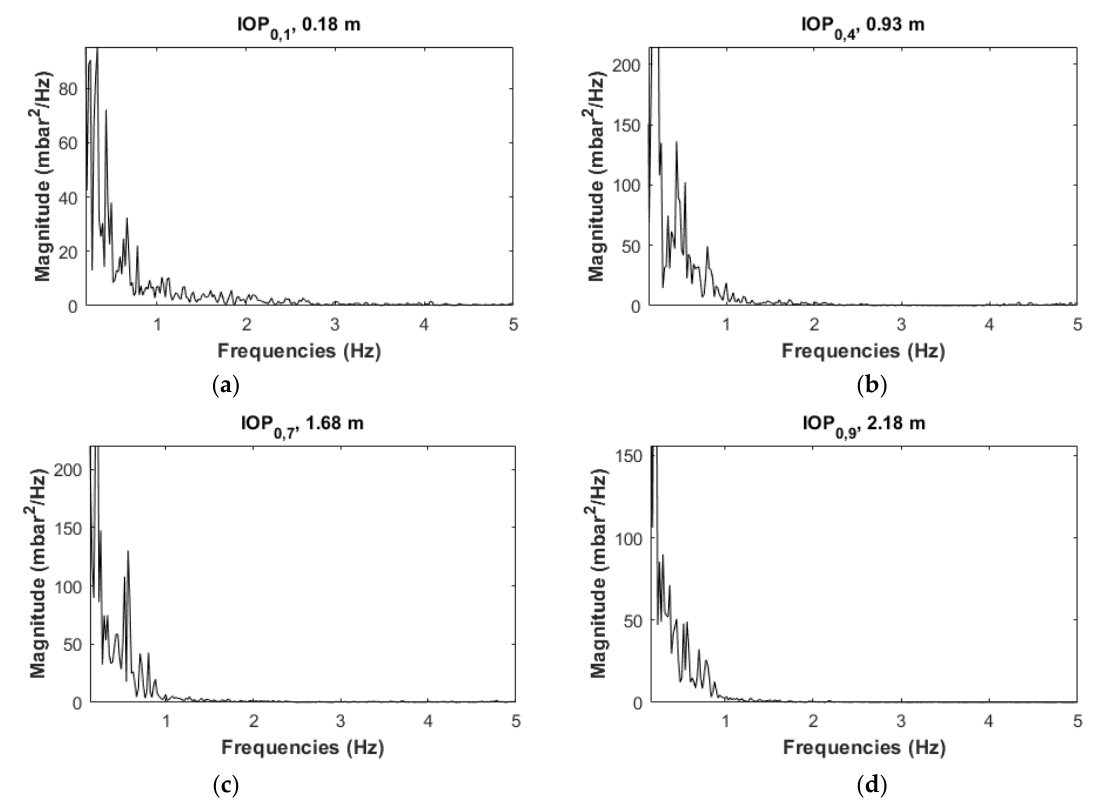
Figure 11. Four spectra obtained at various heights for the same experimental configuration, at U air − U mf = 0.53 m/s and G p = 69 kg/m 2 s: ( a ) 0.18 m, ( b ) 0.93 m, ( c ) 1.68 m and ( d ) 2.18 m.